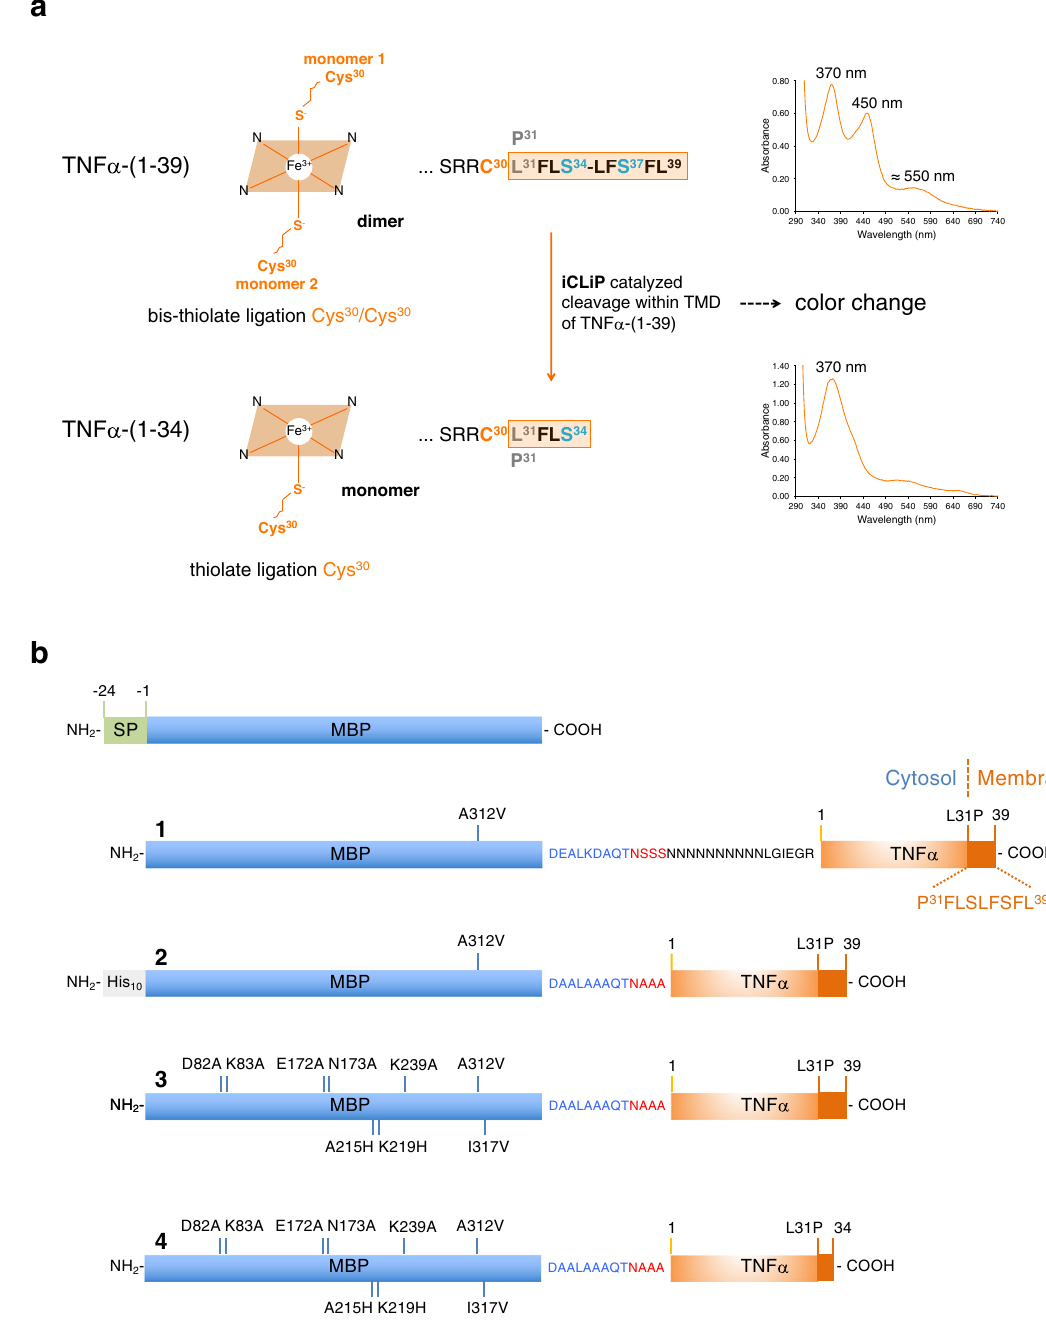
Fig. 1 The principle of the heme binding tag-based iCliPSpy assay. a Bis-thiolate ligation of heme depends on dimerization of TNF α -(1-39). Cleavage within the TMD part L31-L39 of TNF α -(1-39) prevents dimerization by removing or disrupting the S 34 XXS 37 motif and results in mono-thiolate ligation of heme by Cys30. Bis- thiolate and mono-thiolate-coordinated heme molecules differ in their absorbance spectra, so that TNF α -(1-39) (substrate for intramembrane-cleaving protease) and TNF α -(1-34) (product of intramembrane proteolysis) with bound heme show different colors. Because of increased heme binding af fi nity, we use TNF α -(1-39)- L31P instead of TNF α -(1-39) wt as heme binding tag. b MBP-TNF α constructs used in our studies [lacking the signal peptide (SP) of E. coli MBP shown at the top of the fi gure]. 1 , MBP- TNF α -(1-39)-L31P with a poly-Asn linker was used in our initial study to characterize heme binding of TNF α 25 . 2 - 4 MBP-TNF α fusions used in the present study all contain the peptide DAALAAAQTNAAA, which links MBP to TNF α -(1-39). The topology of MBP-TNF α -(1-39) fusion proteins is exemplary shown for construct 1. For co-production with I-CLiP RseP, construct 3 [named MBP mut -TNF α -(1-39)-L31P] was used, which contains additional eight substitutions that further increase af fi nity for amylose, reduce the surface entropy and increase the crystal-packing interactions between adjacent MBP molecules 31 pETDuet-1 vector (Supplementary Table 1 and Supplementary plates (Fig. 2a). A general disadvantage of the T7 expression Note 1) and the recombinant plasmids were transformed into system is the already existing low protein expression without E. coli T7 Express cells. For in vivo experiments, expression of IPTG induction, also called leaky expression. However, leaky MBP fusions was performed without IPTG induction on agar expression can be an advantage, especially in the expression of